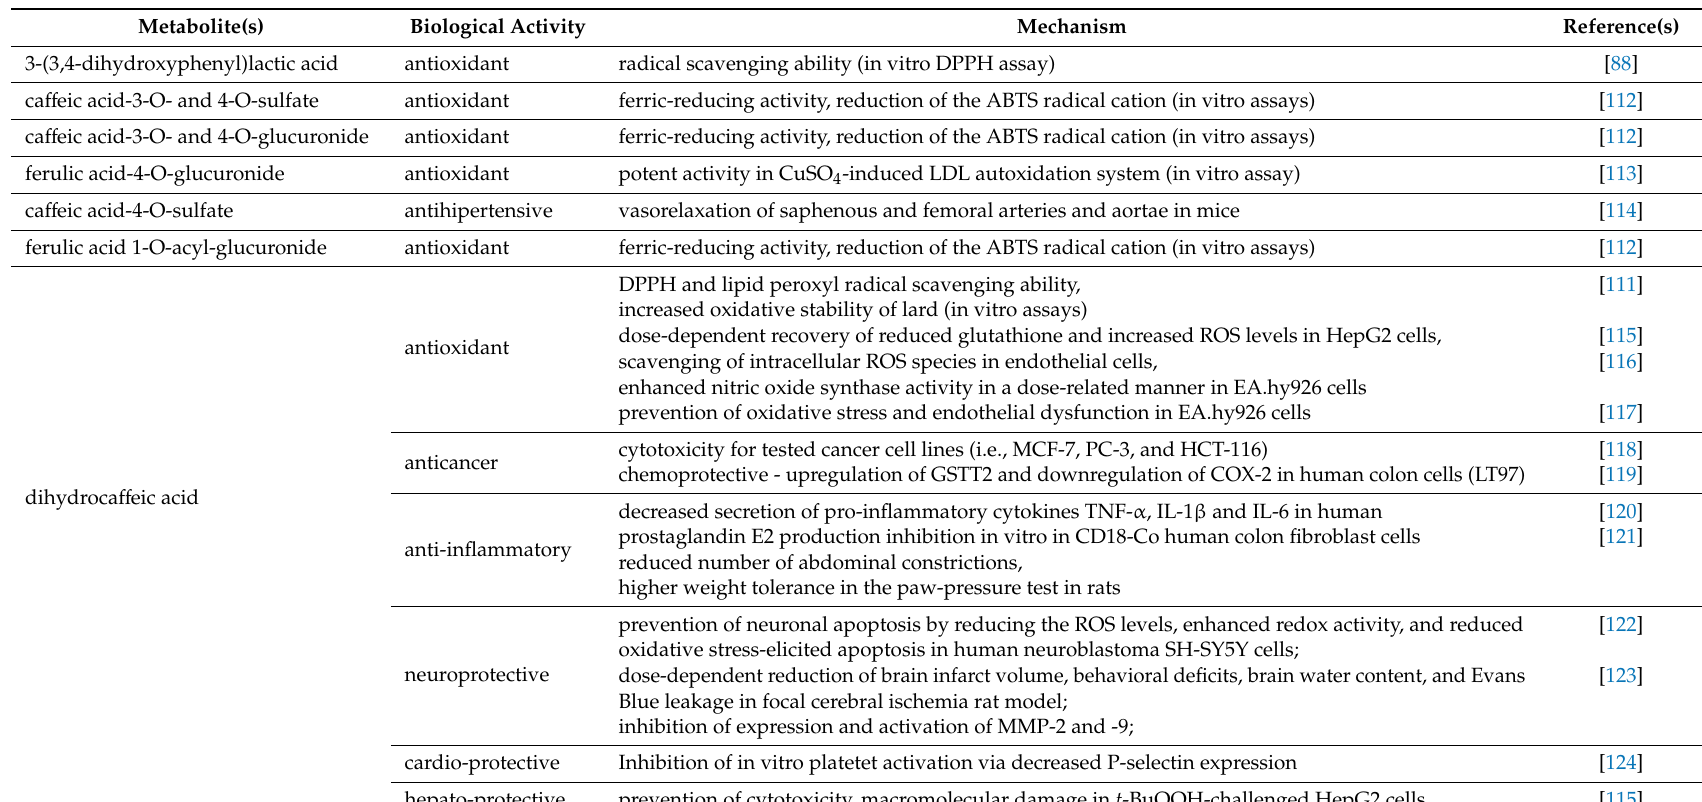
Table 1. Biological activities and underlying mechanism of major HCAs’